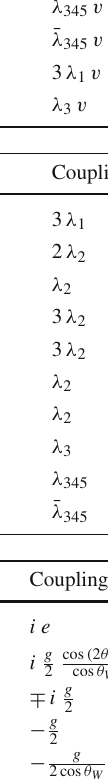
Table 4 Quartic scalar vertices